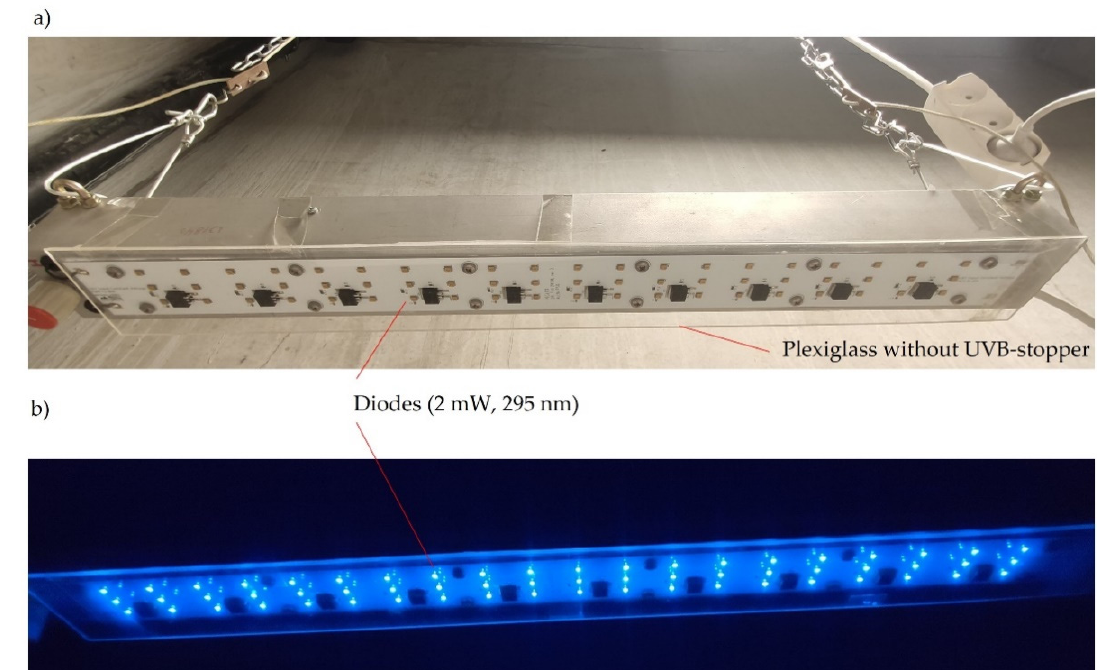
Figure A1. The LED-UVB 295 luminaire turned off ( a ) and turned on ( b ). The irradiance (W/nm/m 2 ) from the luminaire was measured using a spectroradiom- eter (QE65000, Ocean Optics) fiber coupled with a fiber with a Ø1126 µm (BF13LSMA02, Thorlabs) attached to a detector probe (CC-3-UV-S cosine diffuser, Ocean Optics). The detector probe was aligned perpendicular at a distance of 32 cm from the luminaire, and measurements was done at five different positions on every 0.8 nm. The irradiance of the LED-UVB 295 luminaire can be seen in Figure A2.